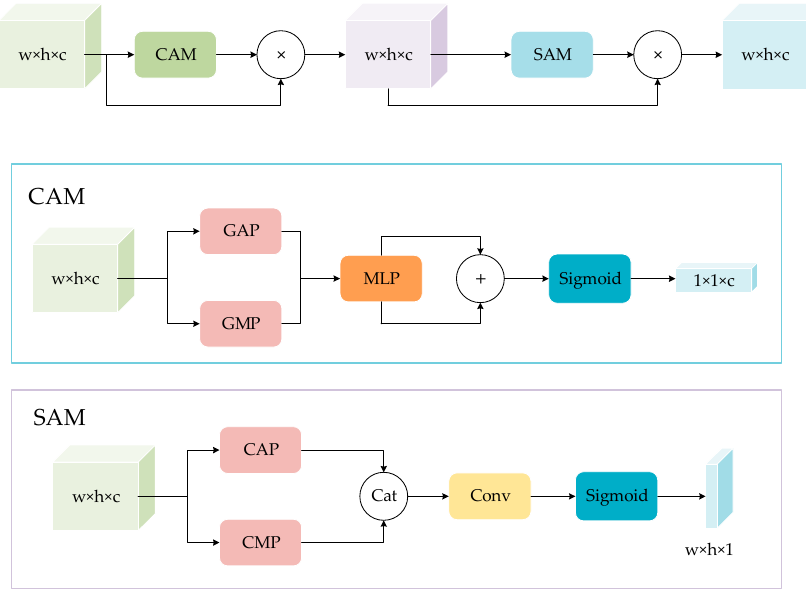
Figure 2. The structure of CBAM. ‘CAM’ and ‘SAM’ denote the channel and spatial attention modules, respectively. Similar to ’GAP’, ‘GMP’ is the max-pooling operation along the spatial dimension. Similarly, ‘CAP’ and ‘CMP’ are the operations along the channel axis, respectively. The results of ‘GAP’ and ‘GMP’ use the identical ‘MLP’, which is composed of sequential fully connected layers.